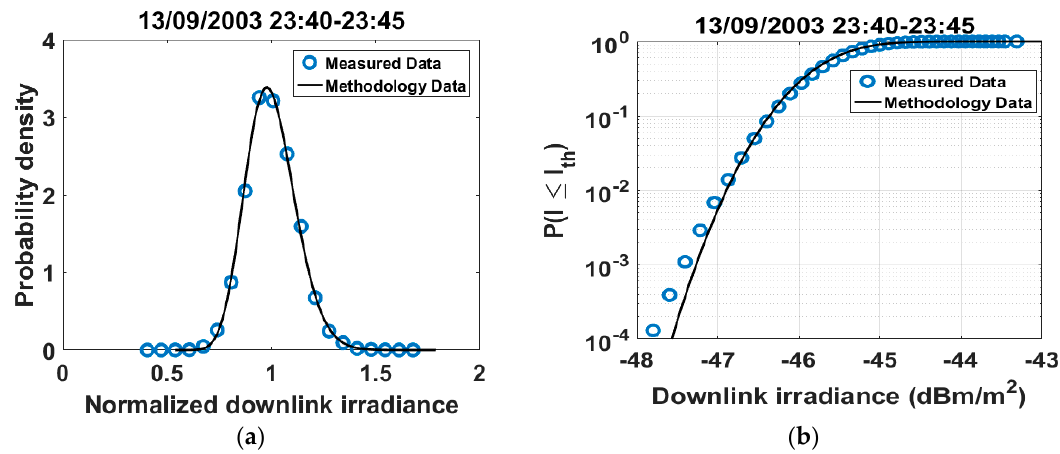
Figure 4. First order irradiance statistics validation for session on 13/09/2003 23:30. (a) Normalized probability density function (PDF) of measured data vs. Normalized PDF of generated data; (b) cumulative distribution function (CDF) of measured data vs. CDF of generated data.